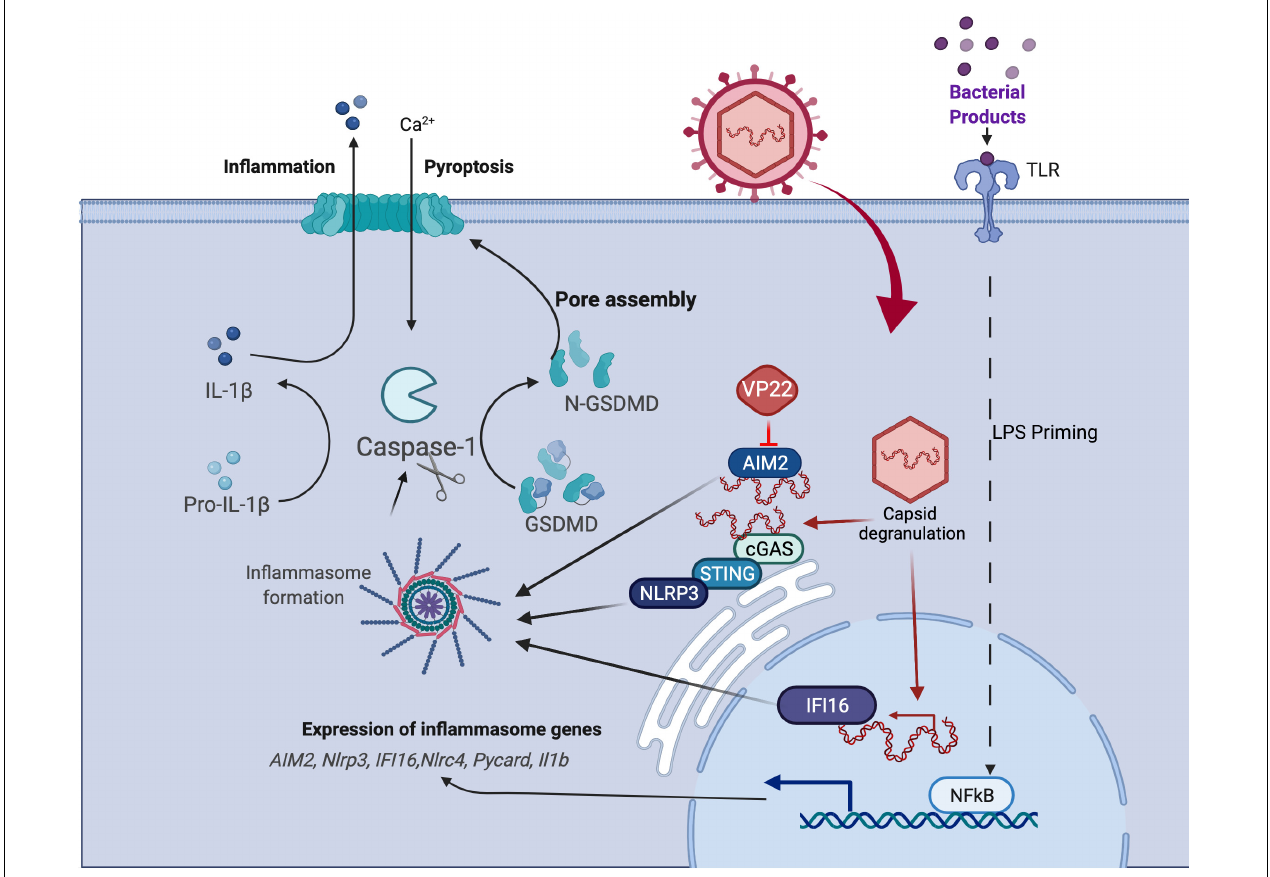
FIGURE 3 | HSV1 manipulation of the pyroptosis pathway. Pyroptosis is defined as GSDM-mediated programmed cell death that is triggered through inflammasome formation and cleavage of pro-caspase 1 to enzymatically active caspase 1 that, in turn, activates GSDM (see text). Studies of virus-mediated pyroptosis rely on in vitro models in which cells are primed to upregulate viral sensors and inflammasome components following LPS stimulation followed subsequently by virus infection. HSV1 infection has been shown to manipulate pyroptosis by AIM2 inflammasome blockade via virus-encoded VP22, although other suppressors may be